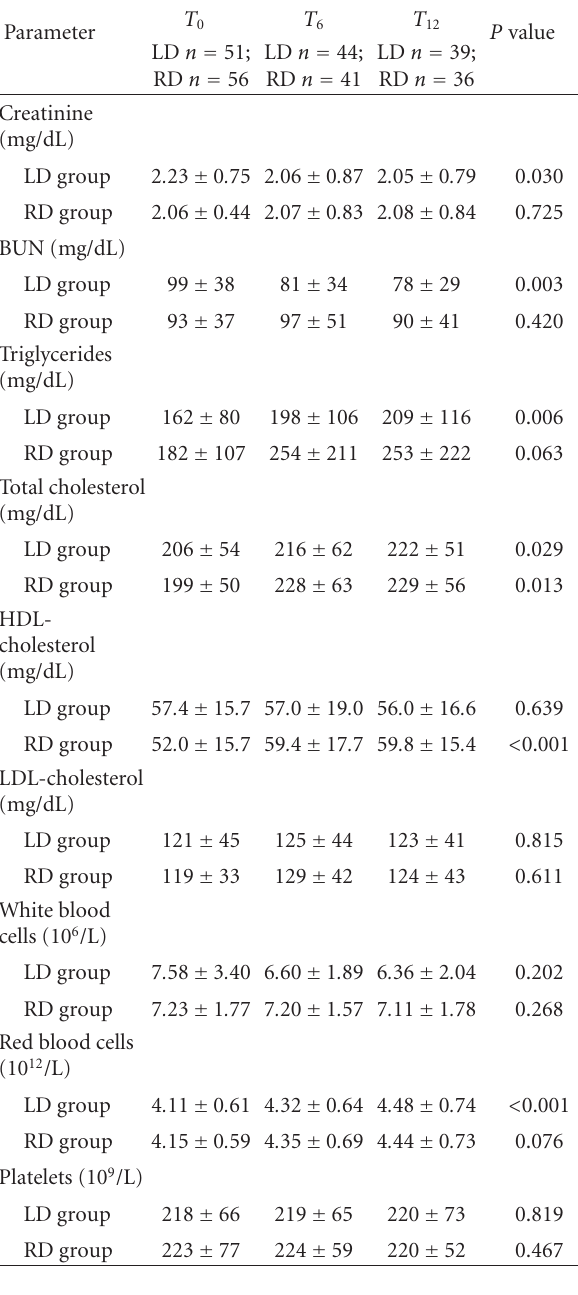
Table 3: Adverse events of everolimus (EVL) during 12 months of Follow-up 1 .